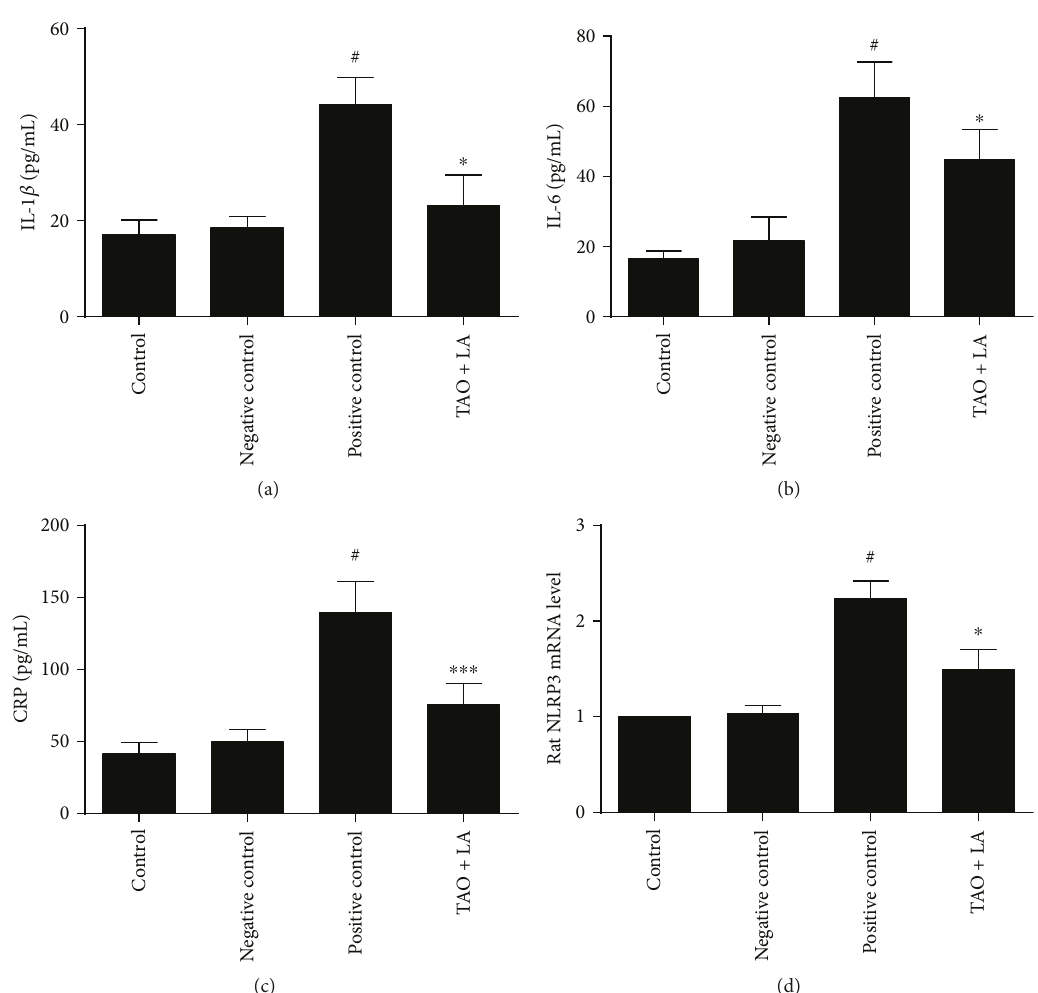
Figure 5: LA reduced the rats ’ in fl ammatory factor levels. Wistar rat serum IL-1 β /IL-6/CRP content was detected using an ELISA (a – c). Lower limb arterial NLRP3 mRNA levels in rats (d). # p < 0 05 versus negative control group; ∗ p < 0 05 and ∗∗∗ p < 0 001 versus positive control